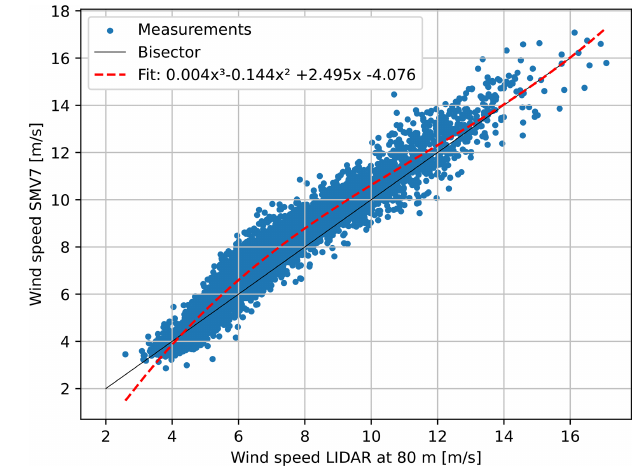
Figure 5. Comparison of wind speed measured by the Windcube lidar at 80m height and the nacelle wind speed of SMV7 in the sector 170–195 ◦ . Fit statistics performed by P5: R 2 = 0 . 94, σ = 0 . 54ms − 1